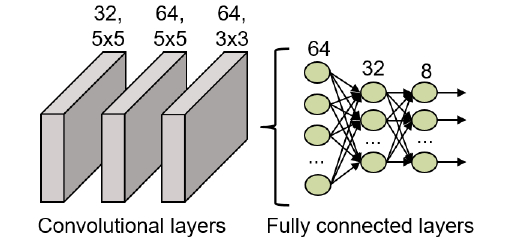
Figure 9. CNN structure implemented for the gesture